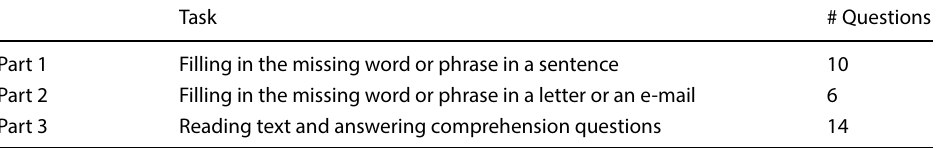
Table 1 The tasks and number of questions in each part of the exam